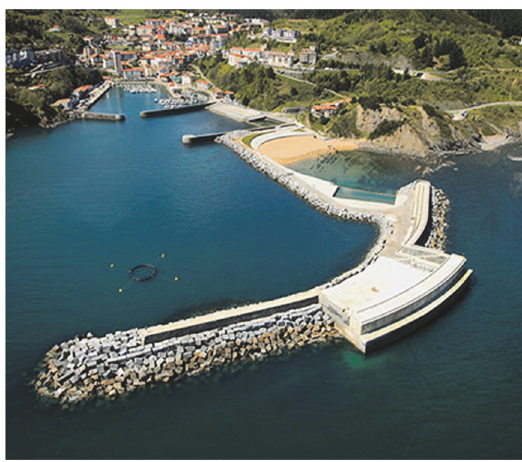
Figure 1: The OWC power plant of